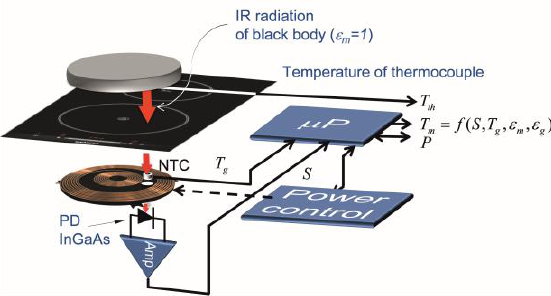
, with a thermocouple. th